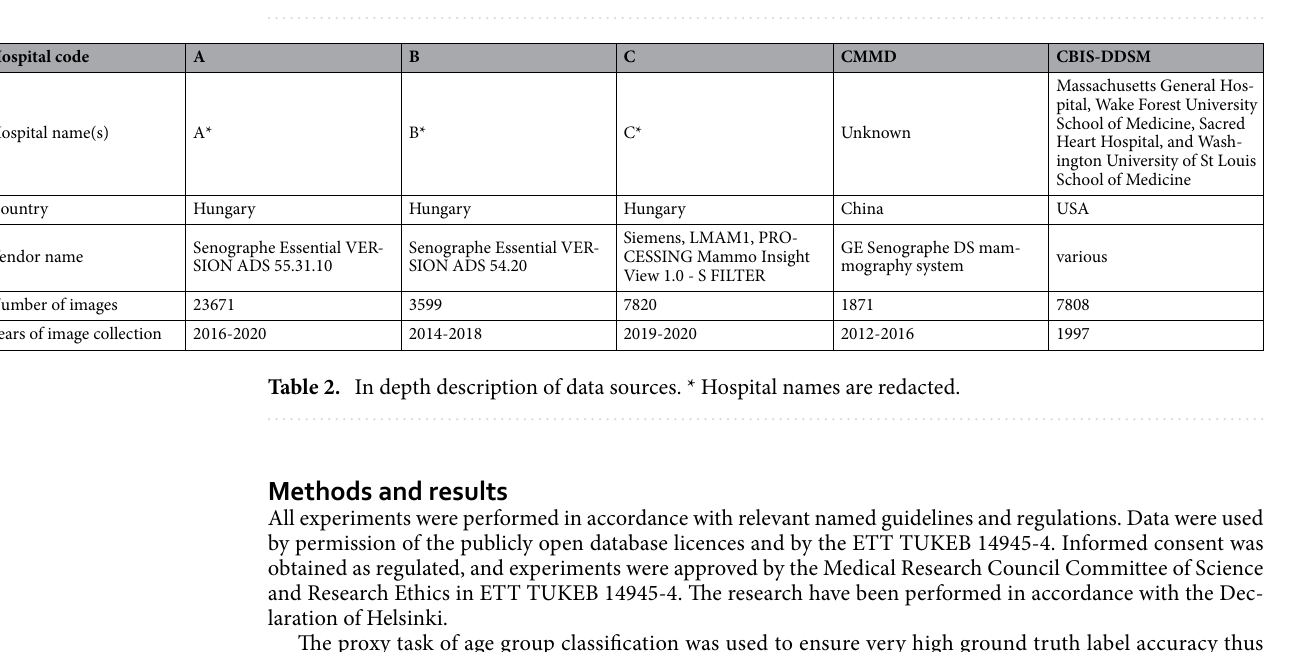
Figure 2. The full dataset is made from 3 Hungarian hospitals:A, B, C and two open source datasets: CMMD 23–26 and CBIS-DDSM 26–28 . All images underwent the same pre-processing pipeline prior to experiments. Row 1 : Example images*. Row 2 : Age distributions for each dataset with 20 bins, x axis is age group. Row 3 : Mean gray level histogram for each dataset after pre-processing on a scale of (0–255).*Data usage statement*— The images were chosen as the most “average-looking” so as to best reflect the broad dataset they were selected from. These images that have no distinctive signature features of interest or medical relevance, this includes breast implants and surgical markings. In order to anonymize images we downsized the 3000 px × 4000 px DICOM images to 244 px × 244 px resolution. Full description of datasets vendors and years of collection can be found (see Table 2).